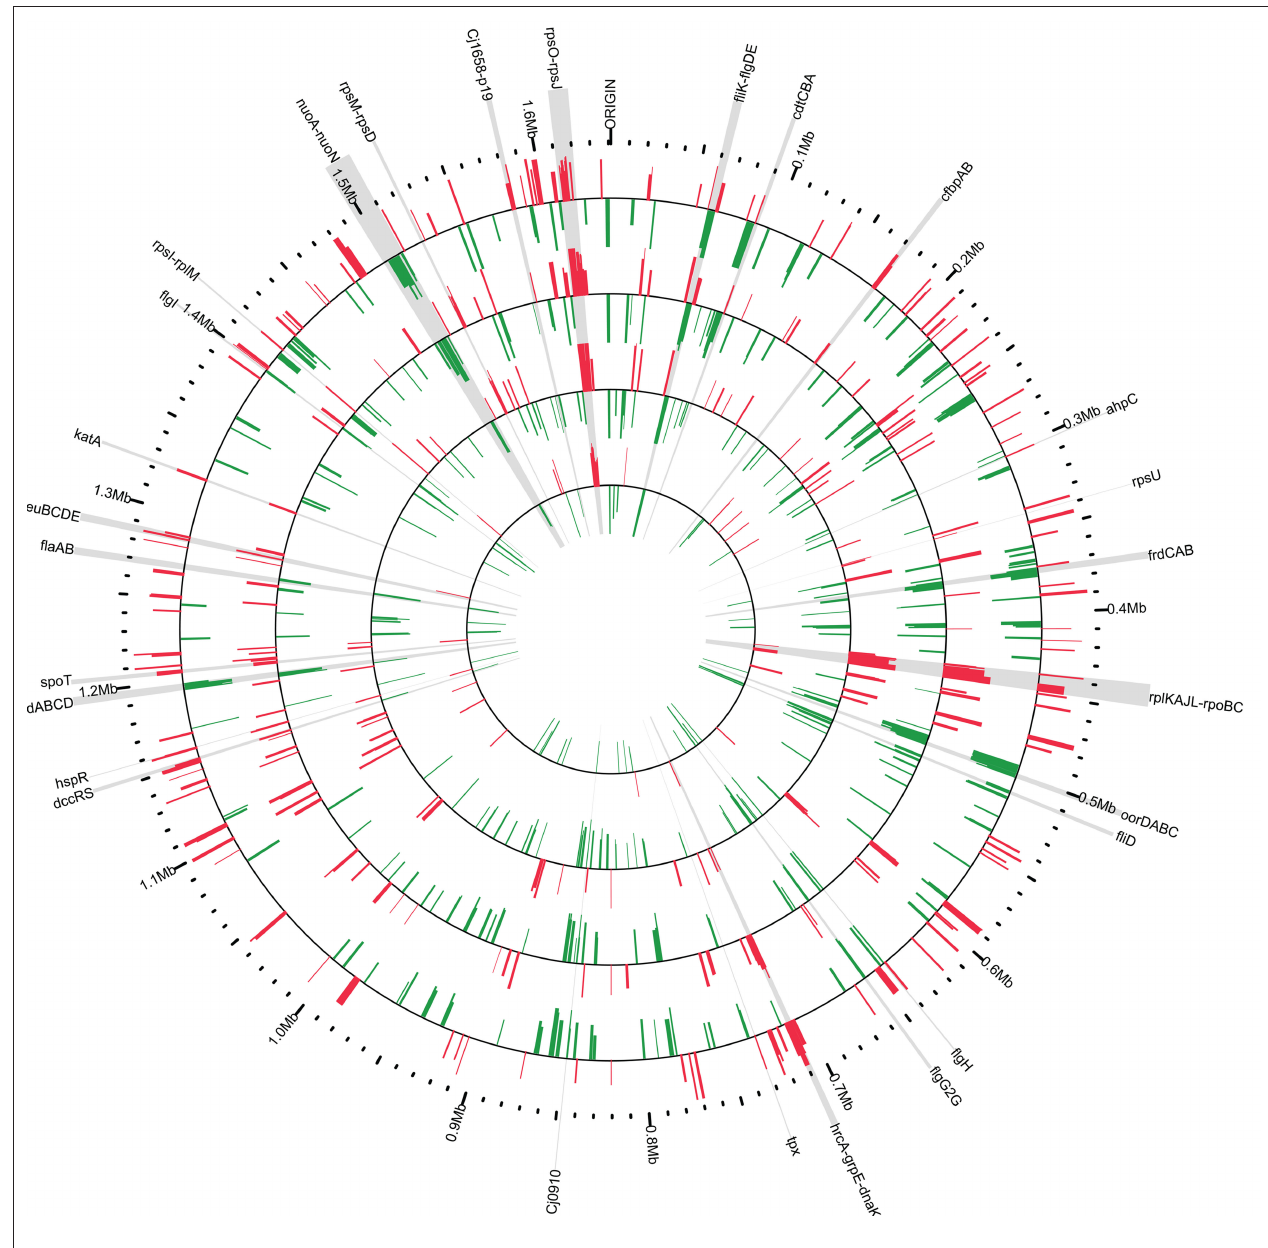
Figure 1 | Chromosomal mapping of Campylobacter jejuni transcriptomes. Genes found to be differentially expressed (fold change ≥ 2, p value < 10 − 3 ) were mapped onto the C. jejuni NCTC11168 genome. Red signifies up-regulation in the tissue chamber while green represents down-regulation. The tracks are scaled from < 0.25- to > 4-fold transcript change with respect to in vitro cultures. The tracks are arranged temporally with the